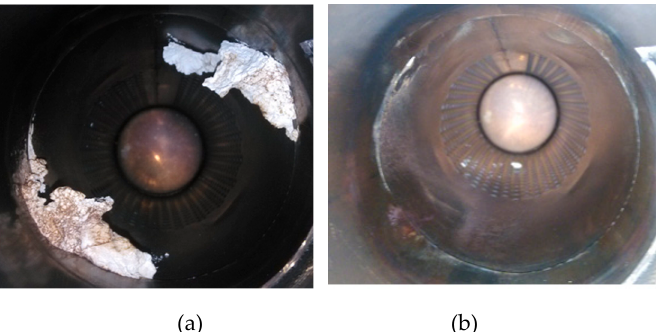
Figure 14. Deposit formation after a 2 h operation at low temperature operation points, ( a ) initial design, and ( b ) optimized design.